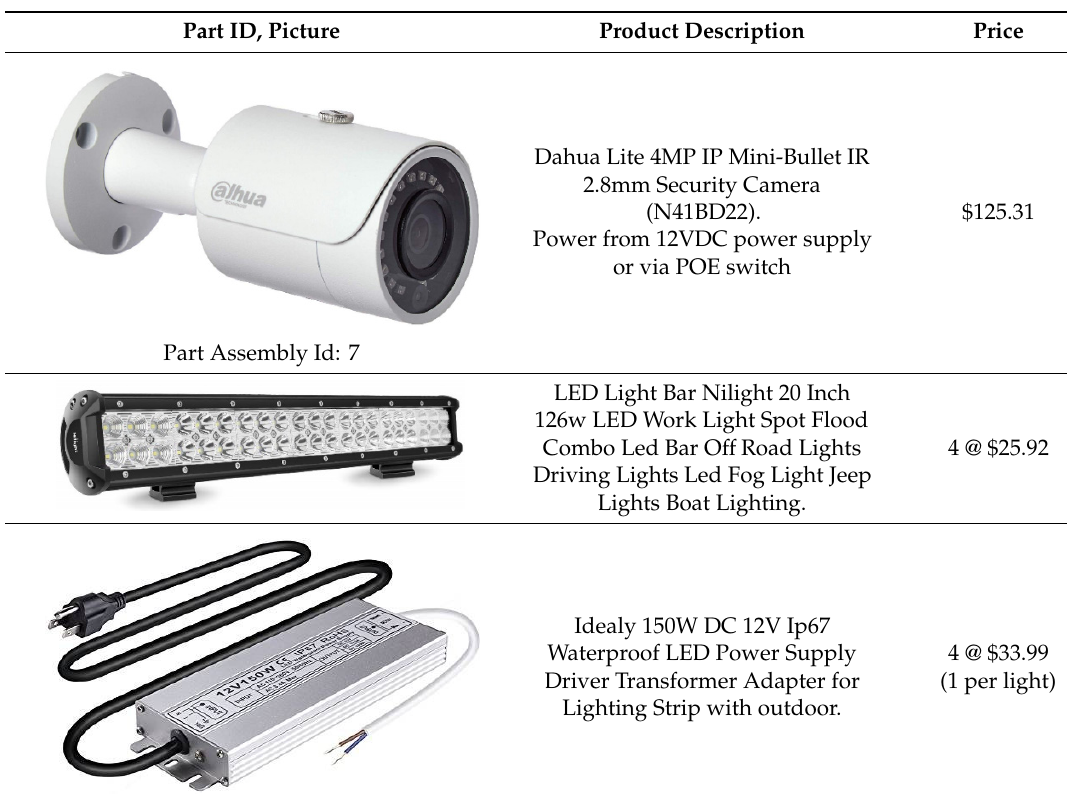
Table 1. Bill Of Materials (Available from Amazon.com).